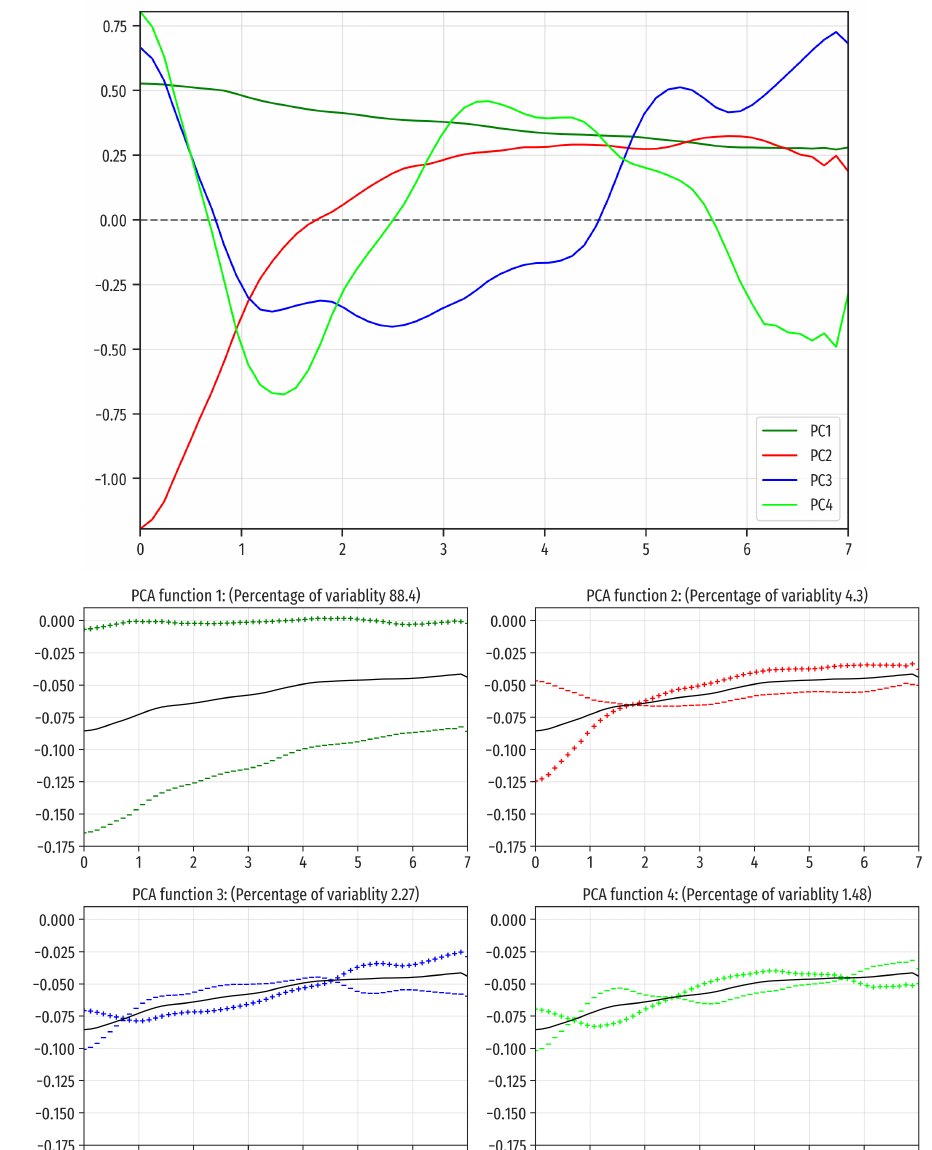
Figure 6. Functional principal component analysis results for the wildfire recoveries dataset. The upper plot shows the first four principal functions (with eigenvalues λ 1 = 0.020670, λ 2 = 0.001005, λ 3 = 0.000530, and λ 4 = 0.000346). The lower plots show the mean (black solid line), and the mean plus/minus a constant times each principal function. The percentage of variance explained by each component is indicated in the